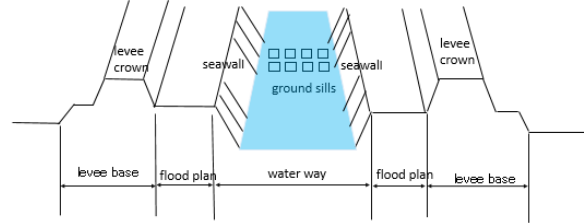
Figure 1. River administration facilities[Yamatogawa River